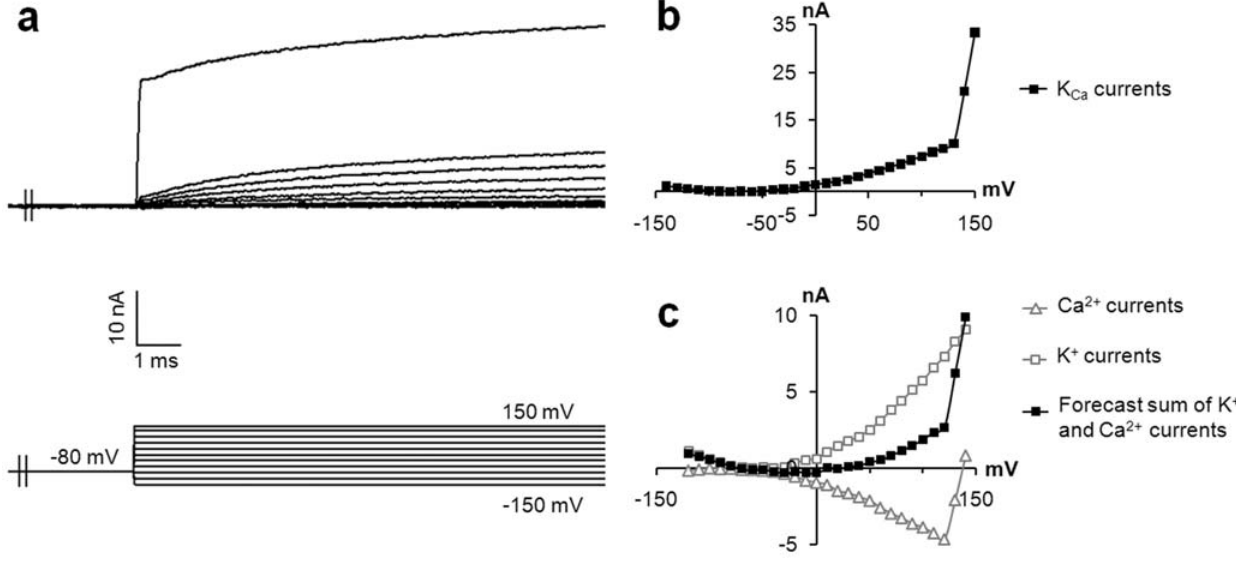
Figure 5. Ca 2 + -activated K + channels in MCs. In three recordings, a sharp increase of outward current was detected, suggesting the presence of BK Ca channels, which have already been described in MCs. (a) Representative voltage-dependent currents activated in response to a series of depolarizing pulses. (b) The current-voltage curve demonstrated a marked increase of the conductance around + 130 mV, suggesting the involvement of different currents. (c) In order to determine whether these currents correspond to both Ca 2 + and K + currents, the two current-voltage curves from a previous recording were added. The pattern of the forecast current to voltage relationship (black squares) corresponded to the recorded currents.